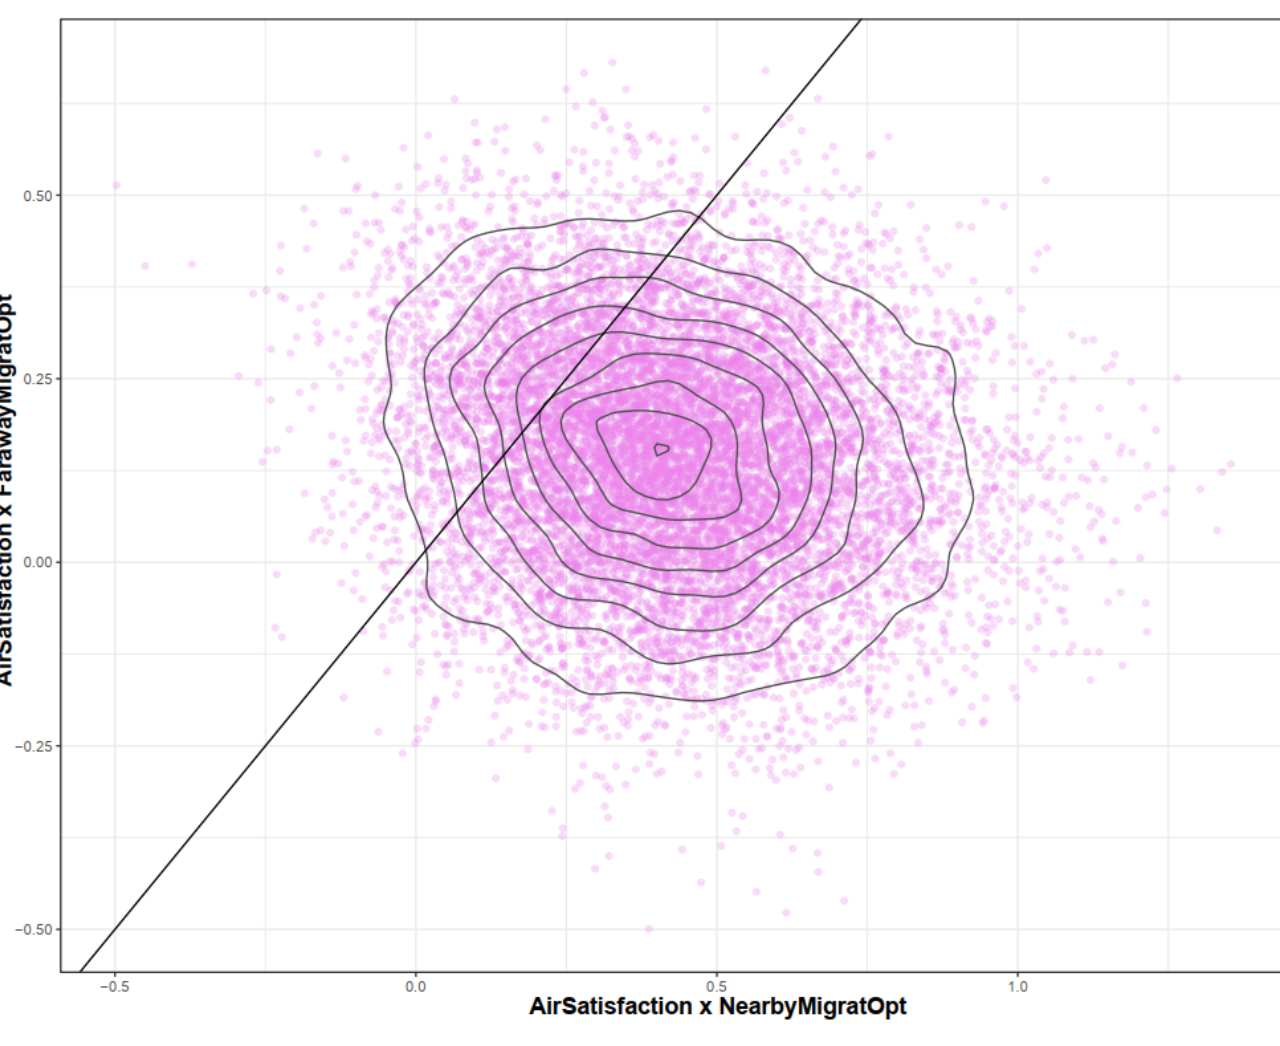
Figure 5. Pairwise distribution plot for Model 1 ′ s AirSatisfaction × NearbyMigratOpt and AirSatisfaction × FarawayMigratOpt .